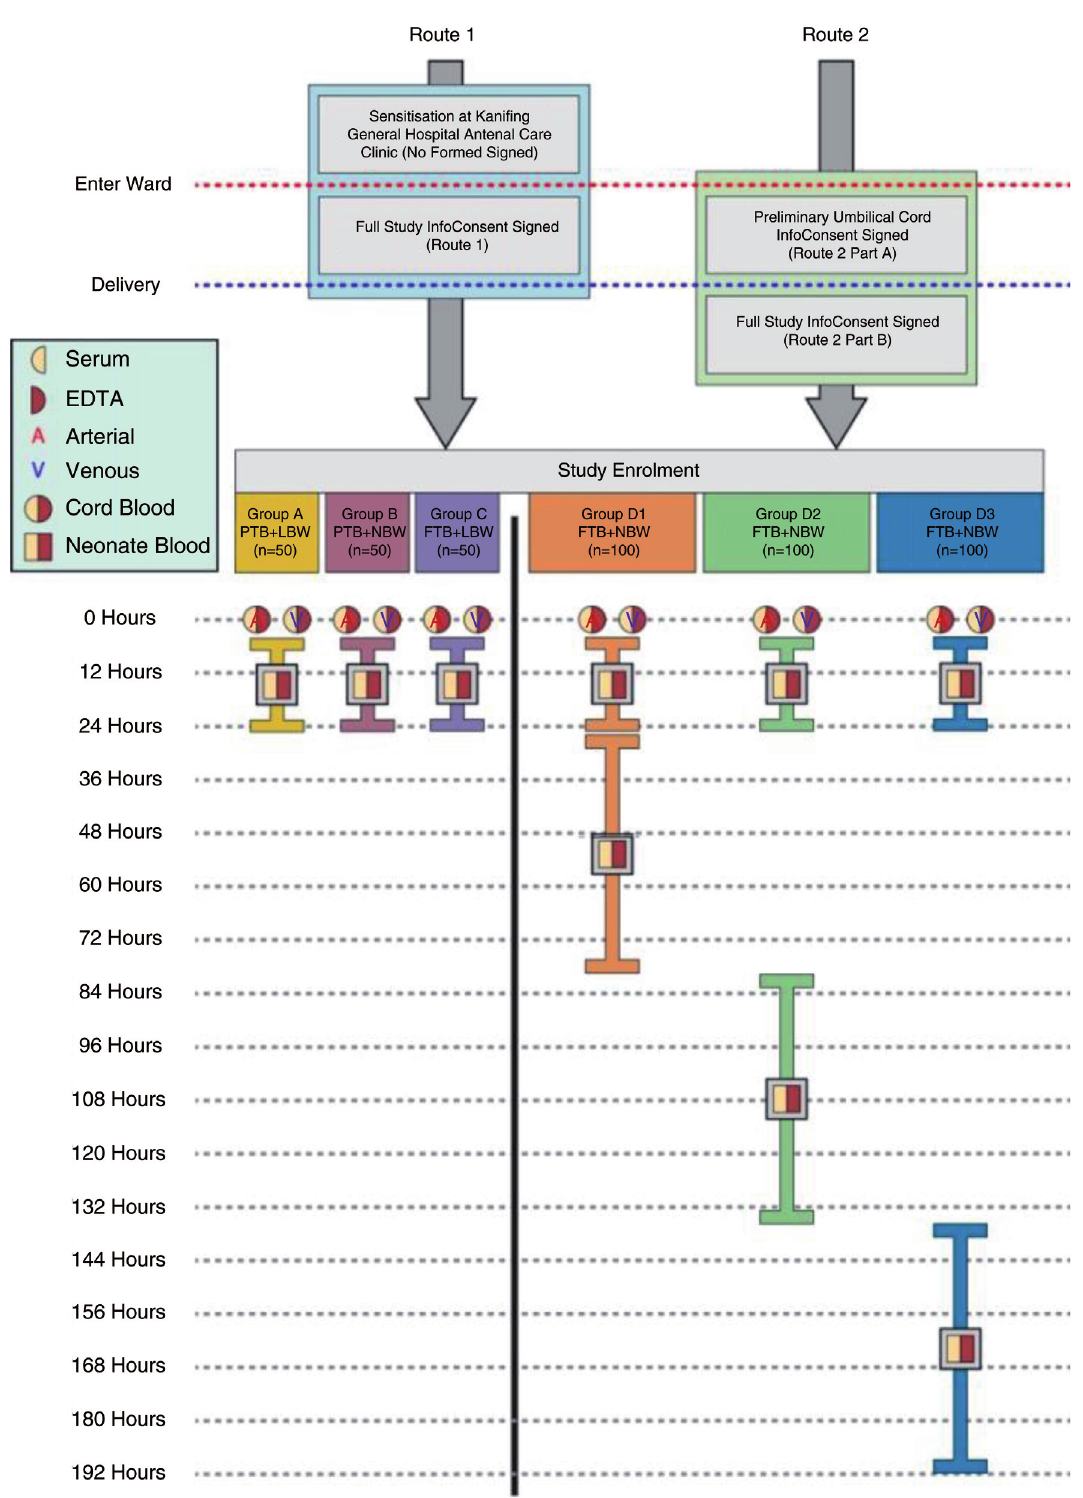
Figure 2. NeoInnate Study enrolment route and blood draw design. Group A contains neonates characterised by preterm birth and low birthweight (PTB+LBW); Group B contains neonates characterised by preterm birth and normal birthweight (PTB+NBW); Group C contains neonates characterised by full term birth and low birthweight (FTB+LBW); Groups D1, D2 and D3 all contain babies characterised by full term birth and normal birthweight (FTB+NBW).